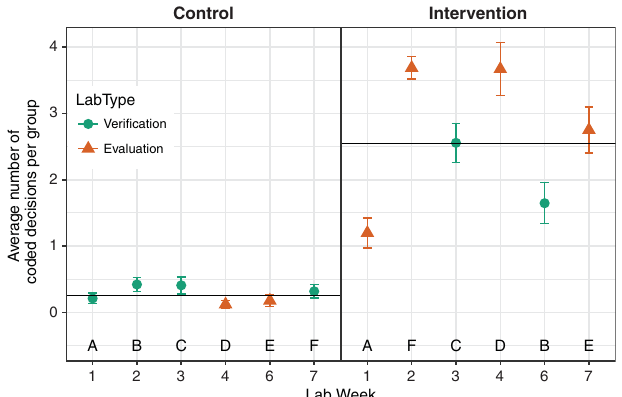
FIG. 4. Average number of coded decisions per group across labs, conditions, and lab types. The error bars represent the standard errors of the means. The horizontal lines indicate the condition average across labs. The lab activity labels associated with each lab week are indicated along the x axis.